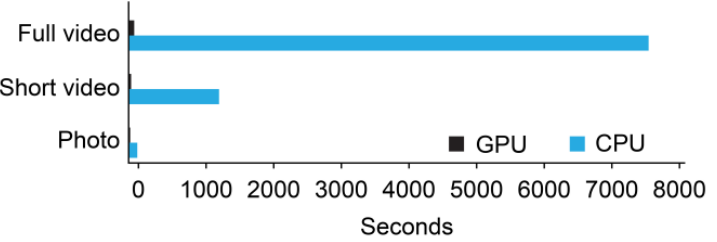
Figure 3. Execution performance analysis (unit: seconds). Table 1. Executive performance analysis.